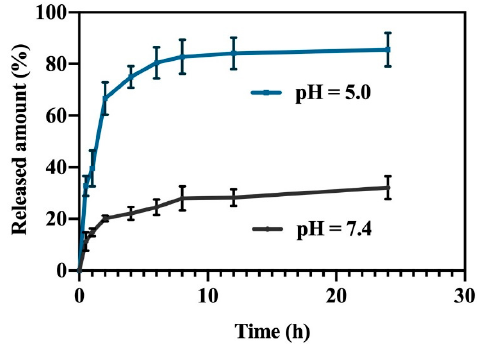
Figure 3. Release curves of DHM in PBS buffered solution at pH = 5.0 or 7.4. Data are representa- tive of three independent experiments. of three independent